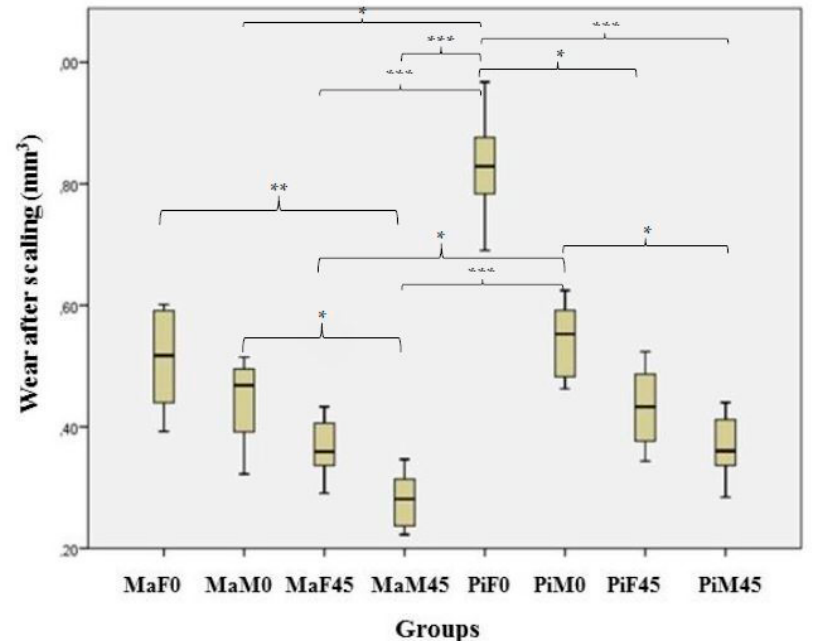
Figure 5. Wear values of the different scaler groups. *Mann–Whitney U posthoc Bon Ferroni Correction, p < 0.05; **Mann–Whitney U posthoc Bon Ferroni Correction, p < 0.01; ***Mann–Whitney U posthoc Bon Ferroni Correction, p < 0.001.